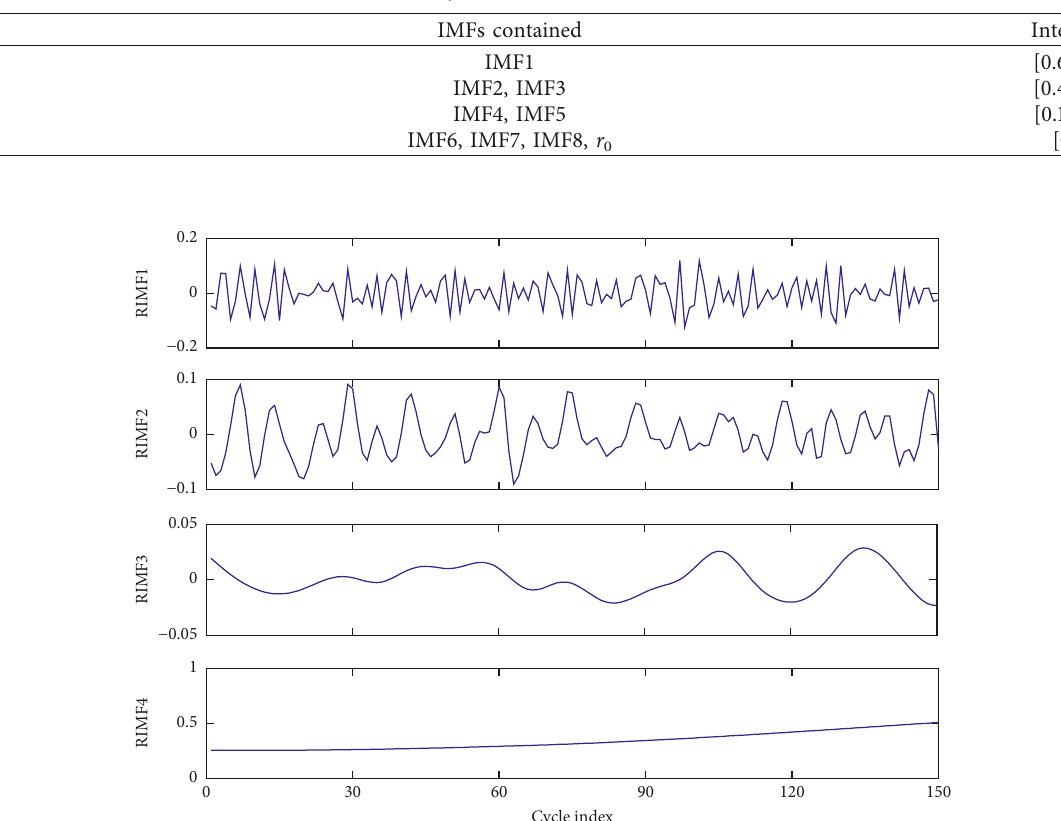
Figure 9: RIMFs reconstructed from the CEEMDAN decomposed